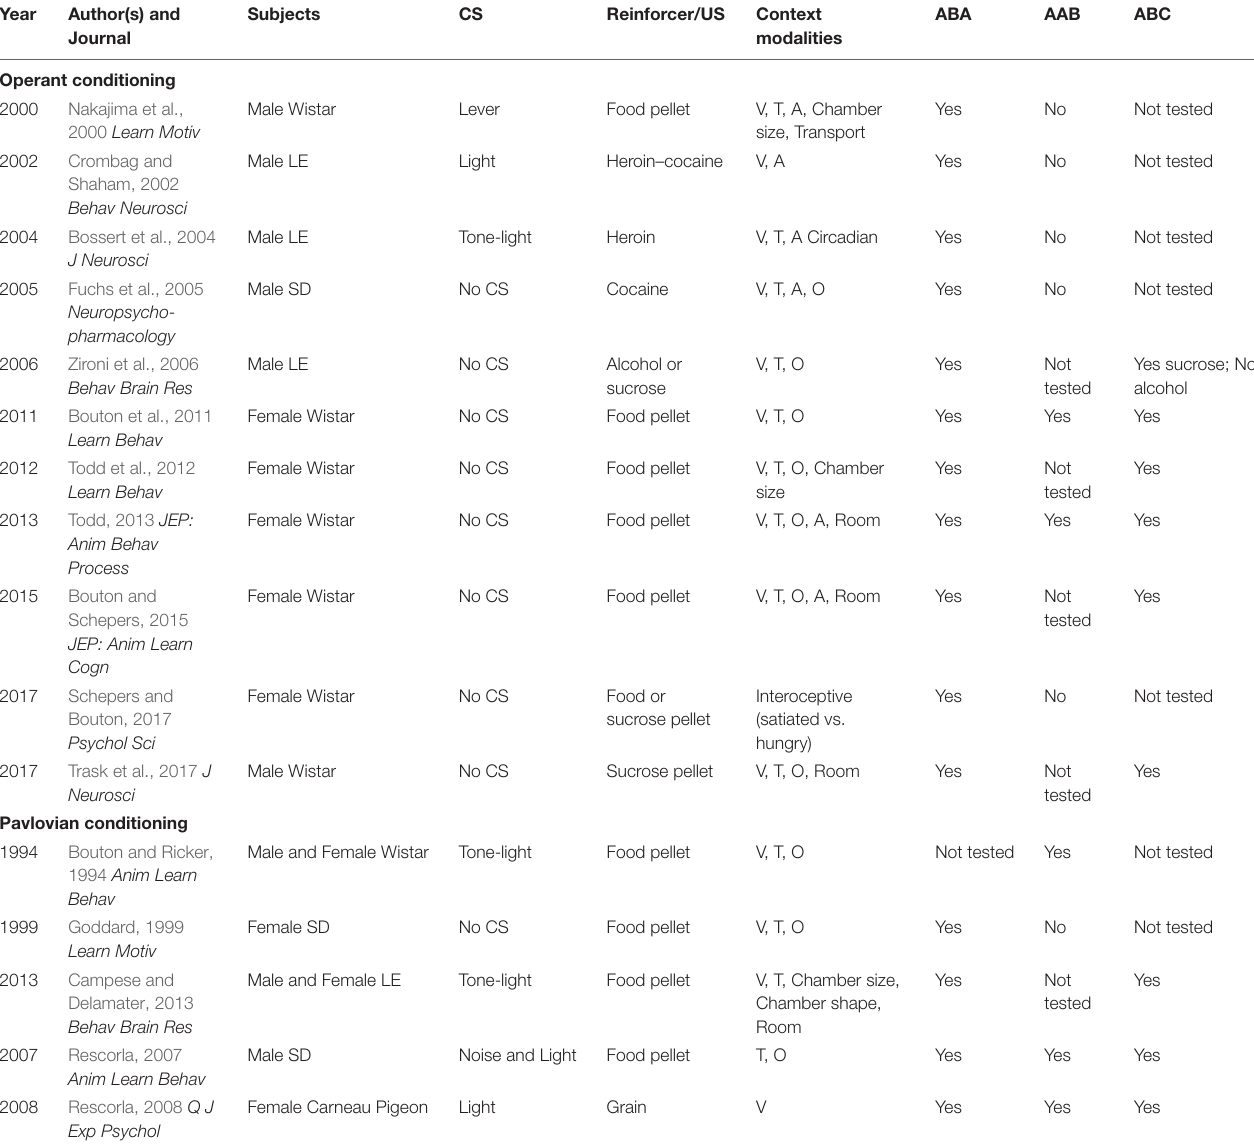
TABLE 1 | Studies that examined ABA renewal in conjunction with either AAB or ABC renewal of appetitive